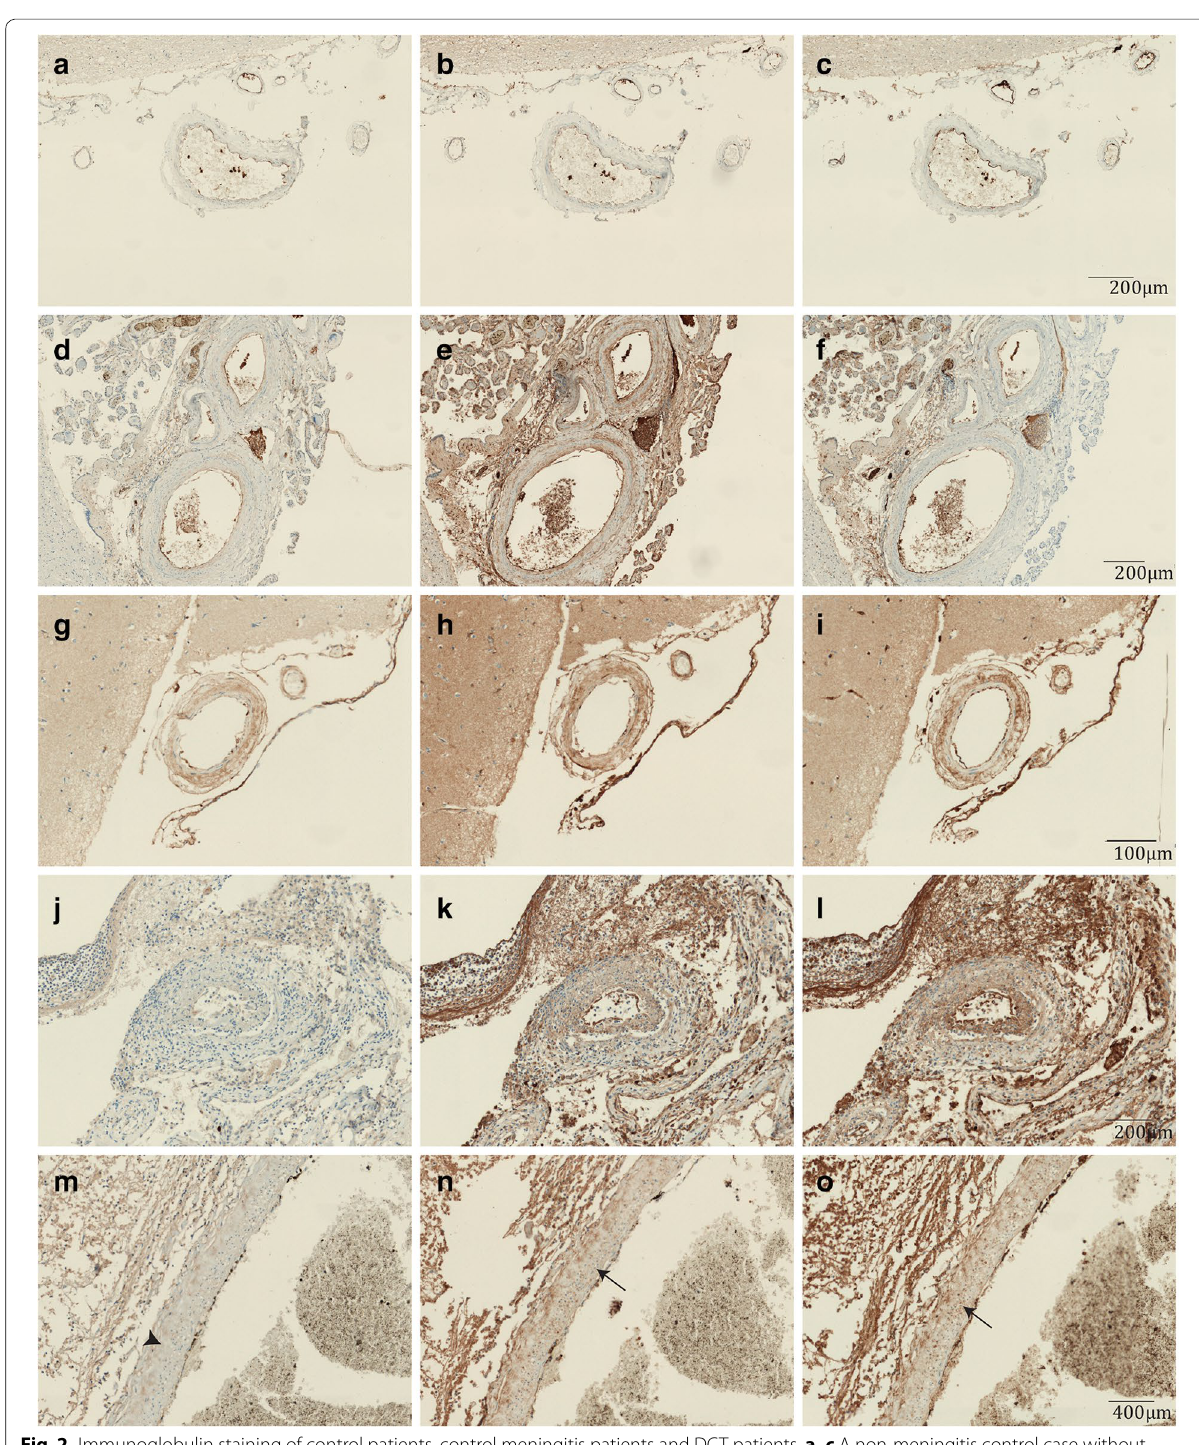
Fig. 2 Immunoglobulin staining of control patients, control meningitis patients and DCT patients. a – c A non‑meningitis control case without immunoglobulin deposition. IgA ( a ), IgG ( b ) and IgM ( c ). d – f A non‑meningitis control case with deposition of IgG ( e ). No IgA ( d ) and IgM ( f ) deposition is seen. g – i A non‑meningitis control case with deposition of IgA ( g ), IgG ( h ) and IgM ( i ). IgG is also deposited in tunica media (arrow). j – l Representative image of immune globulin deposition in both DCT and control meningitis cases. IgG ( k ) and IgM ( l ) deposition can be seen in all three arterial layers. There was stronger IgM stain observed than IgG. IgA ( j ) was in most cases absent. m – o Immunoglobulin deposition in artery without inflammation. IgG ( n ) and IgM ( o ) were seen in all three arterial layers including media of a non‑DCT meningitis case (arrows). Little IgA ( m ) was observed only in tunica adventitia (arrow